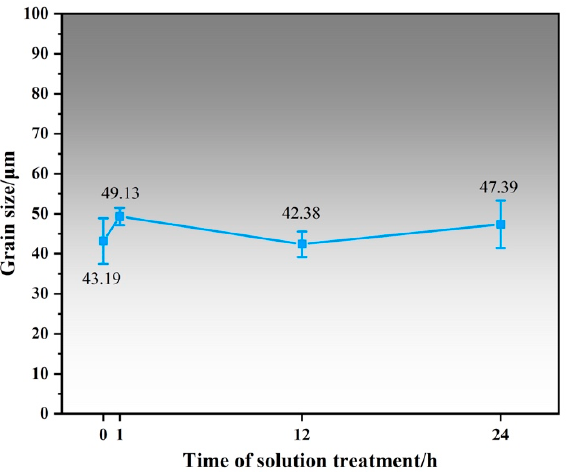
Figure 4. Grain size line chart of as-cast alloy and solid solution alloy. The area fraction broken line diagram of the LPSO phase of the alloy after solution treatment at 450 ◦ C for 1 h, 12 h and 24 h is shown in Figure 5 according to the statistics of Image Pro Plus software. It is found that with the prolongation of solution treatment time, the area fraction of the LPSO phase precipitated inside the alloy particles increased, which were 8.30%, 20.03% and 21.26%, respectively. This is the same conclusion drawn from the metallographic and XRD patterns shown in Figure